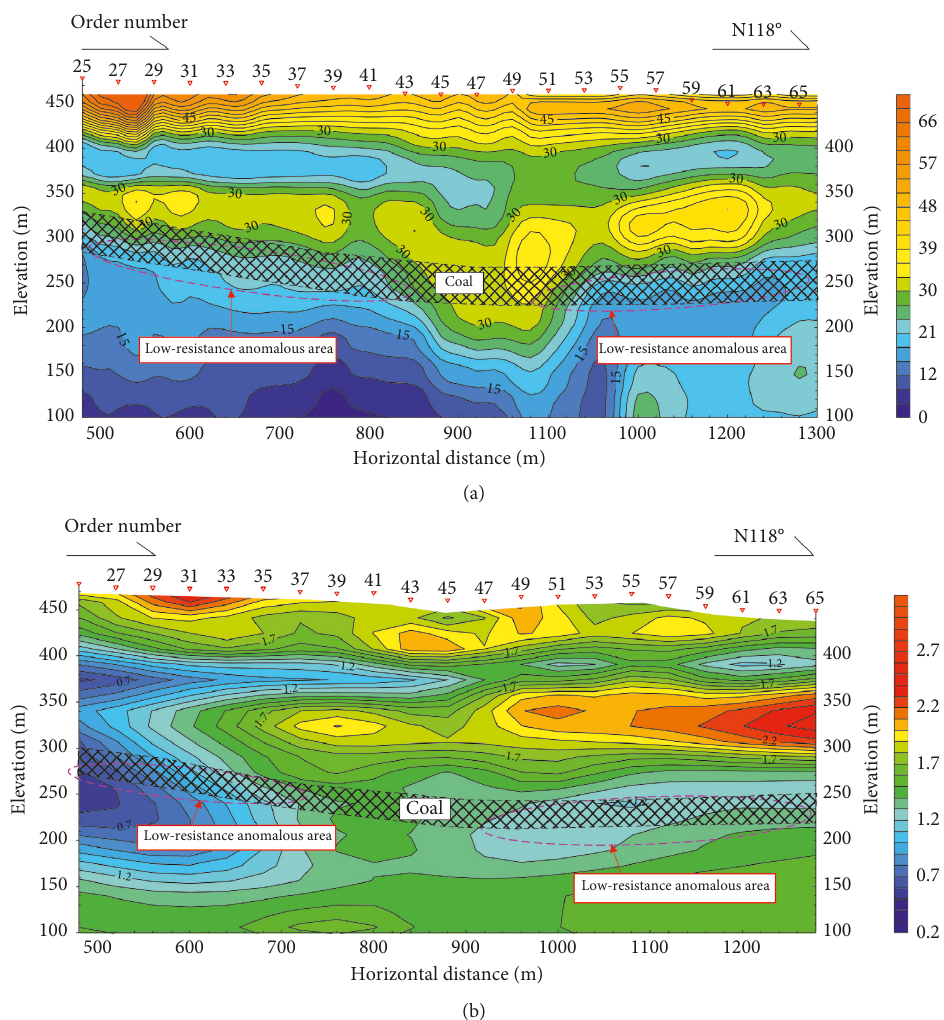
Figure 12: Resistivity sections obtained by different methods. (a) Inversion of the resistivity profile from line 9 of the TEM method. (b) Inversion of the resistivity profile from line 9 of the CSAMT